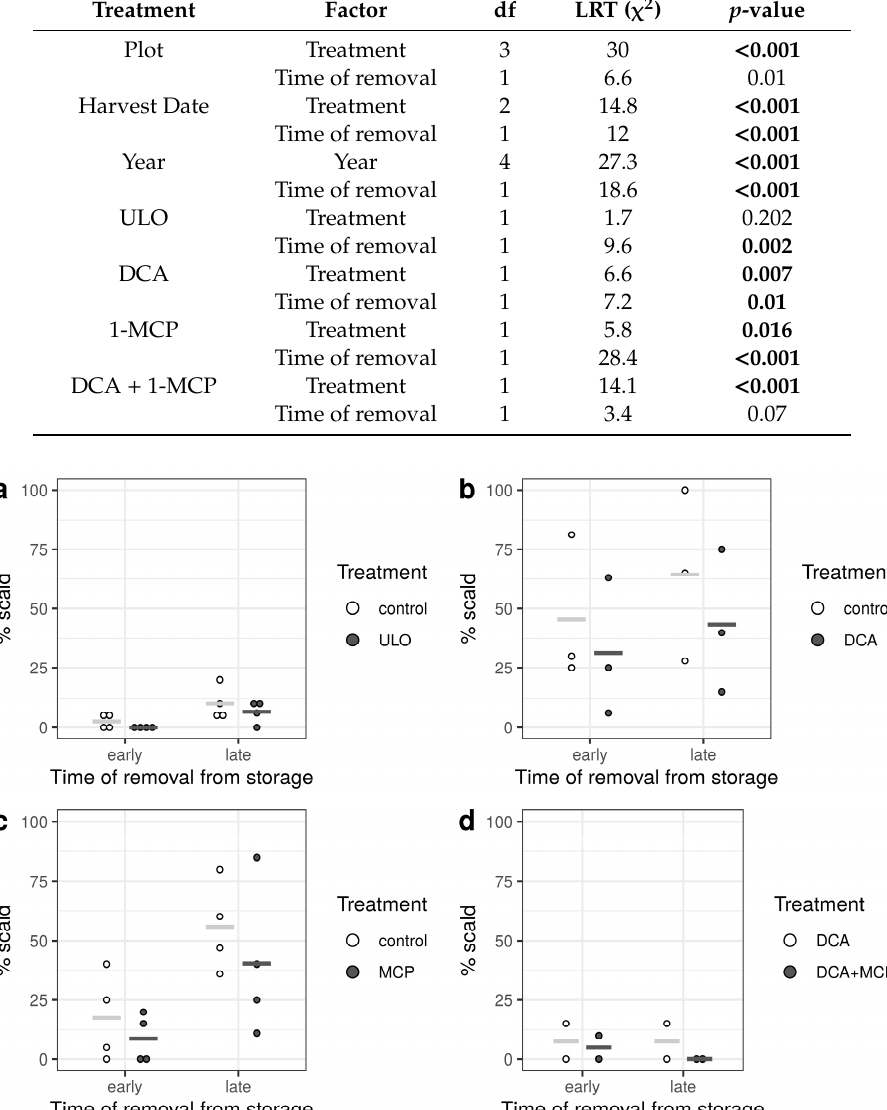
Figure 3. Postharvest factors influencing superficial scald. Percentage of fruits with superficial scald on Malus × domestica cv. Ladina stored under di ff erent storage conditions after 7 days “shelf life” at 20 ◦ C when removed from storage after 5 months (early removal) or after 7 months (late removal). ( a ) Ultralow oxygen treatment (2014, two plots, two harvest dates each); ( b ) Dynamic controlled atmosphere storage (2017, three plots); ( c ) 1-MCP treatment (2013, two plots, two harvest dates each); and ( d ) combined DCA and 1-MCP treatment (2018, two plots). Dots represent measured data points and horizontal lines denoting the means.